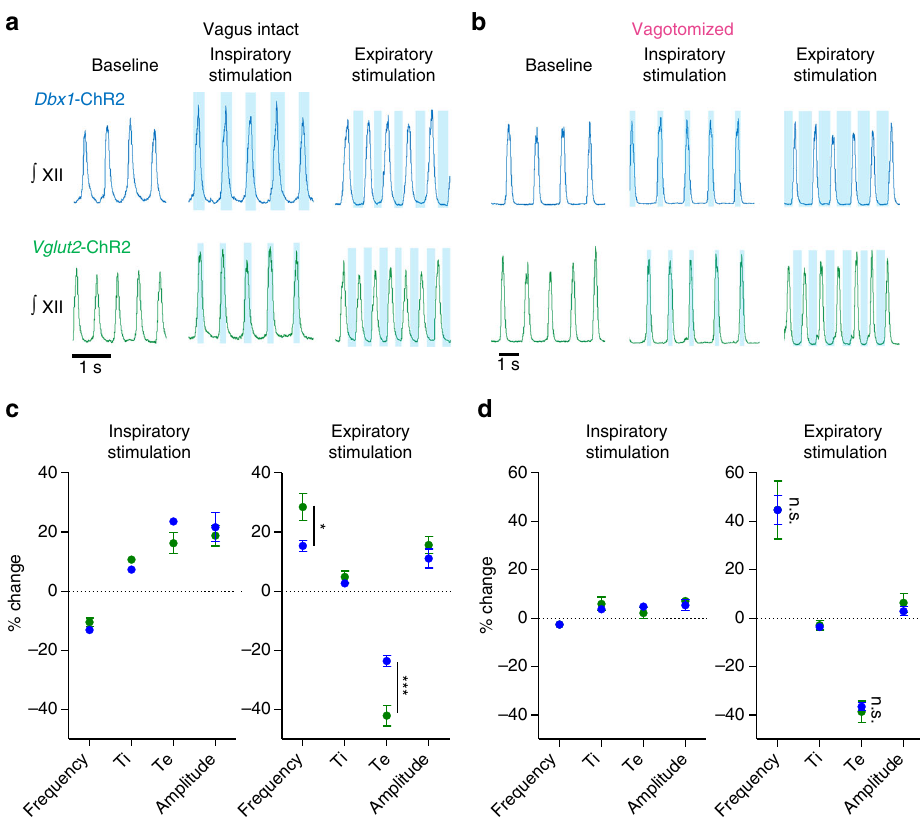
Fig. 8 Differential frequency control of overlapping excitatory preBötC populations is speci fi c to expiratory stimulation in vagus-intact, but not in vagotomized, mice. a , b Representative XII nerve activity during respiratory phase-speci fi c inspiratory or expiratory preBötC stimulation in Dbx1 -ChR2 and Vglut2 -ChR2 mice with the vagus intact ( a ) and following vagotomy ( b ). c , d Average changes in frequency, Ti, Te, and XII burst amplitude during inspiratory and expiratory stimulation in vagus-intact ( c ) (Dbx1, n = 5; Vglut2, n = 6) and vagotomized ( d ) (Dbx1, n = 4; Vglut2, n = 4) mice (mean ± s.e. m.; two-way ANOVA and Bonferonni ’ s multiple comparisons test; * p < 0.05, *** p < 0.001). Note that Vglut2 stimulation only elicits a larger frequency effect than Dbx1 stimulation when sensory feedback inhibition is intact (vagus intact) and when stimulation is speci fi c to the expiratory